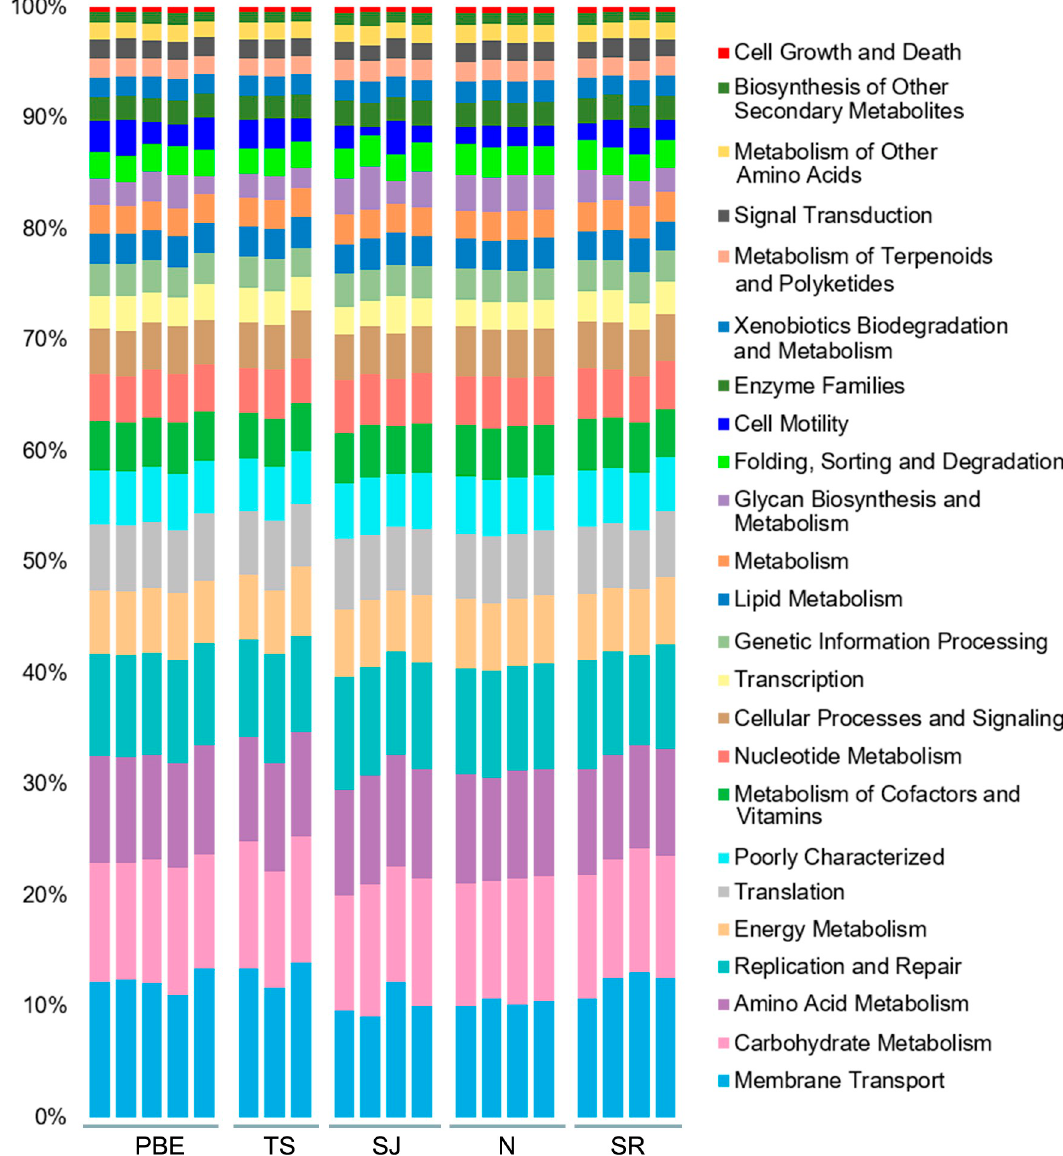
Fig 5. Comparisons of the principal metabolism pathways identified in the harbor seal colonies. Predicted KEEG metabolism pathways for the harbor seal microbiome using